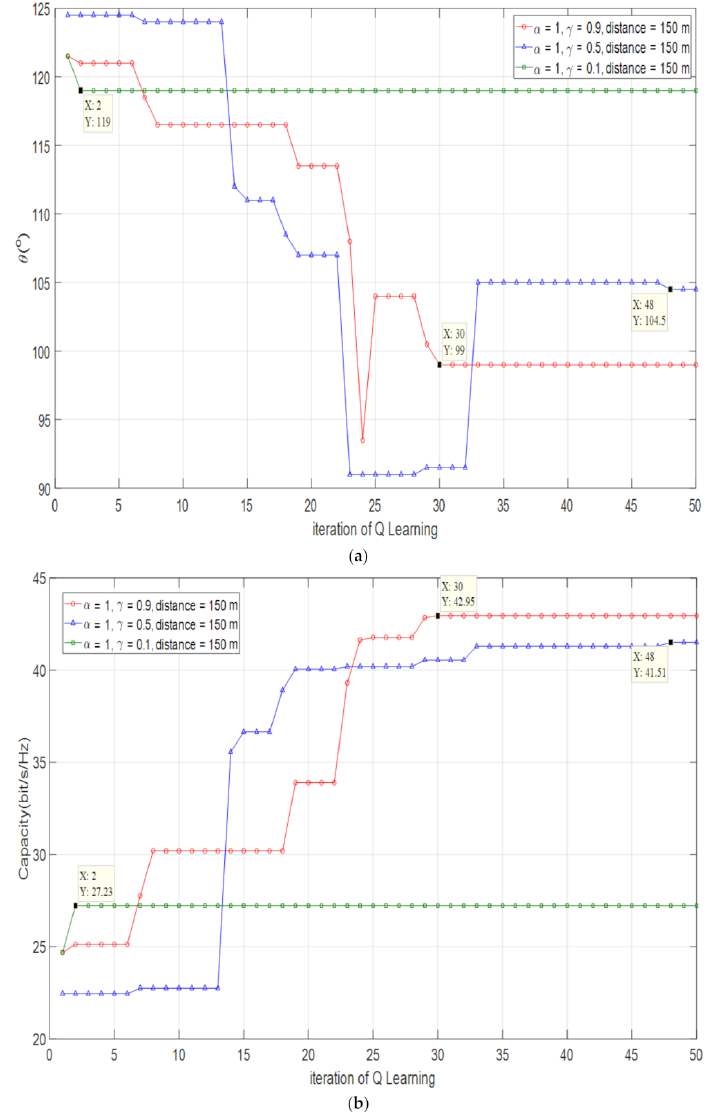
Figure 14. ( a ) Optimized antenna downtilt angle; ( b ) optimized channel capacity. D = 150 m, α = 1 with different γ